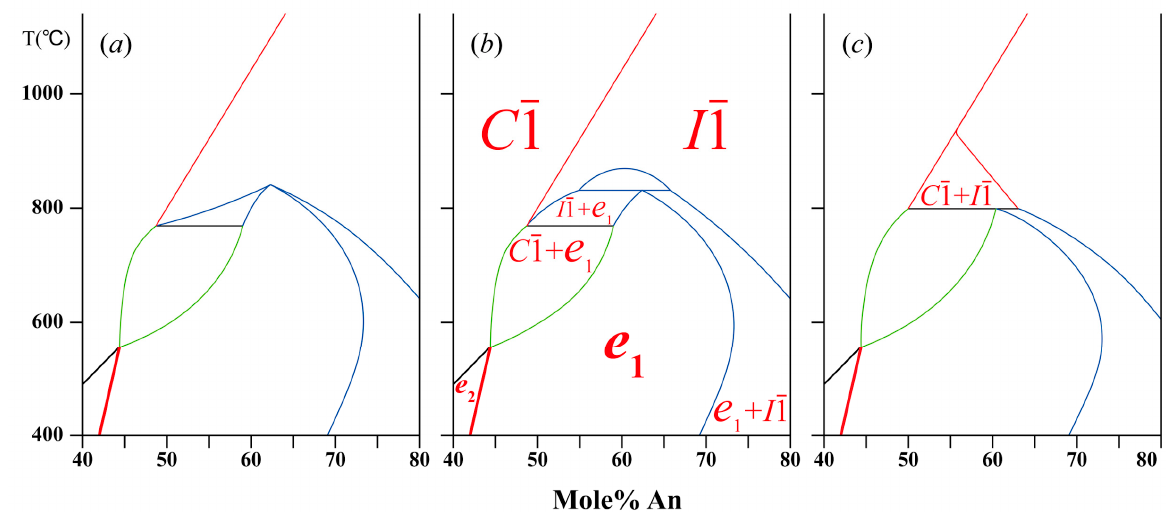
Figure 12. The schematic phase relations around the Bøggild gap showing the topology among the different phase regions, corresponding to the different G-X curves shown in Figure 11. ( a – c ) are corresponding to the cases of ( a – c ) of Figure 11, respectively.